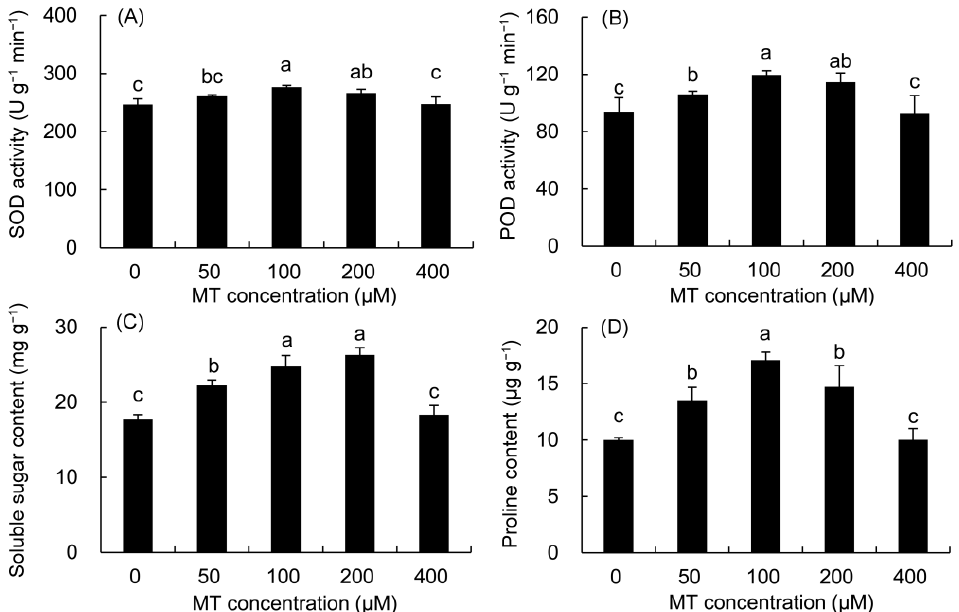
Figure 1. Effects of different concentrations of MT on the activities of SOD ( A ) and POD ( B ) and the contents of soluble sugar ( C ) and proline ( D ) in P. vulgaris. MT: melatonin. Data are means ± standard error; different letters indicate significant differences as determined by the Duncan test ( p ≤ 0.05).